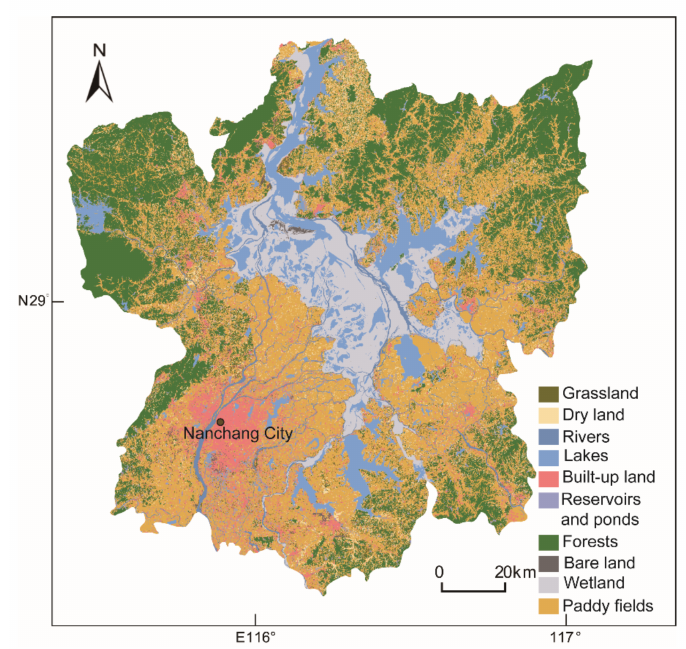
Figure 3. Land use patterns in the Poyang Lake region, as interpreted from Landsat-8 OLI images acquired in